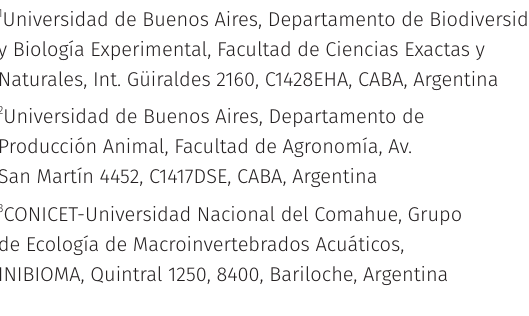
Figure S1. Cumulative precipitation in mm and average maximum air temperature (°C) during 2017 in the study area. Figure S2. Phenology of the caddisfly Verger lutzi in two wetlands (a: Llao Llao 1, b: Llao Llao 2) in relation with water temperature. 1: mating and eggs laying, 2: embryos development, 3: larval development, 4: pupation, 5: adult emergence. Figure S3. Larval size-size structure of Verger lutzi in the sampled wetlands. (a) Llao Llao 1 and (b) Llao Llao 2. August was the month where the wetlands surface was completely frozen. * indicates significant differences between wetlands (t-test p > 0.05). Figure S4. Emergence of adults of Verger lutzi from pupae kept in dry conditions. (a): daily air temperature (mean ± SD) and (b): Cumulative adult emergence during the experimental